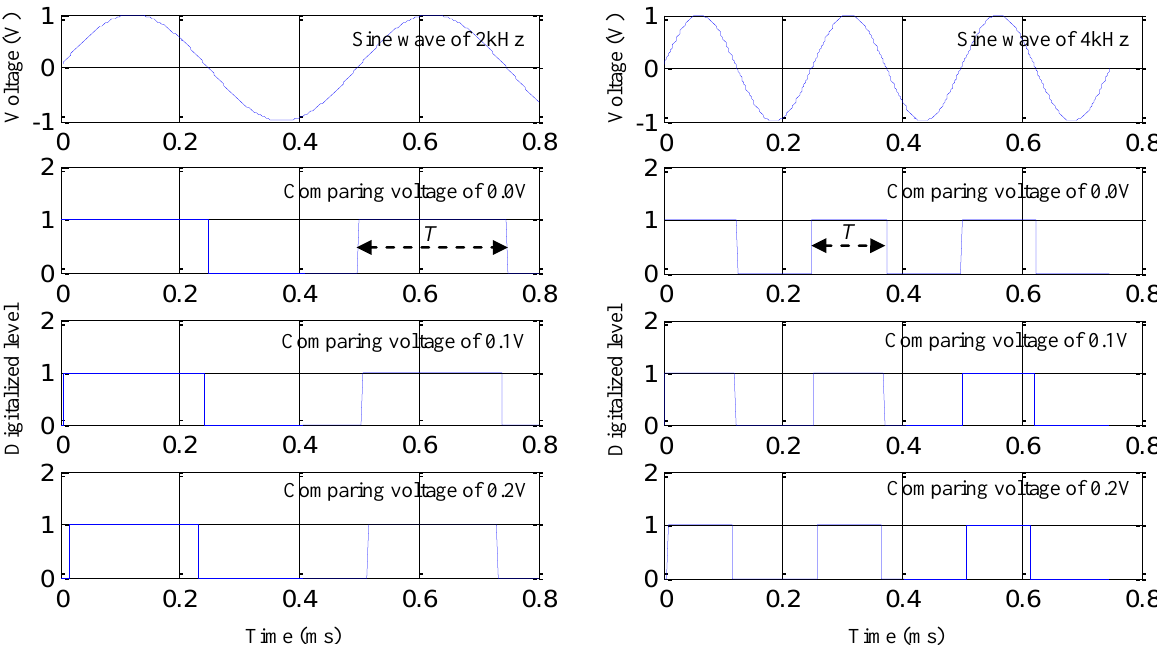
Figure 6. Sine waves and the digital sequences. ( left ) Sine wave of 2 kHz and the digitalized sequences of different comparing voltage; ( right ) Sine wave of 4 kHz and the digitalized sequences of different comparing